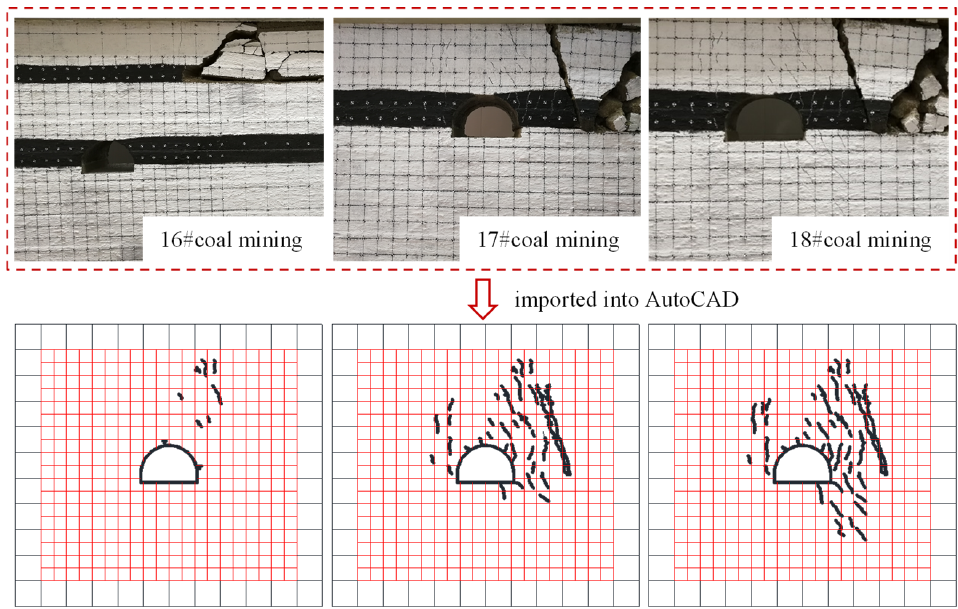
Figure 9. Sketch of fracture distribution and evolution of surrounding rock of coal ‐ rock dstrict rise.